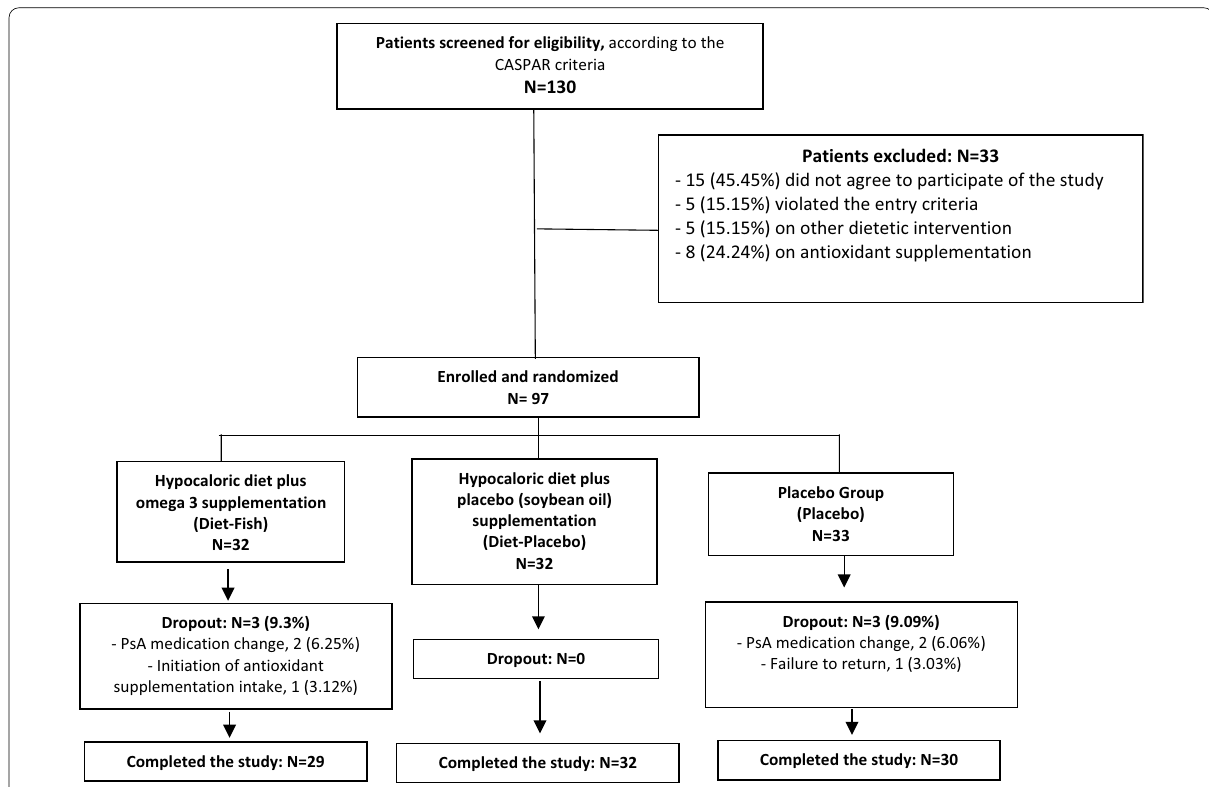
Fig. 1 Patient disposition. Intent to treat analysis. CASPAR: ClASsification of Psoriatic Arthritis